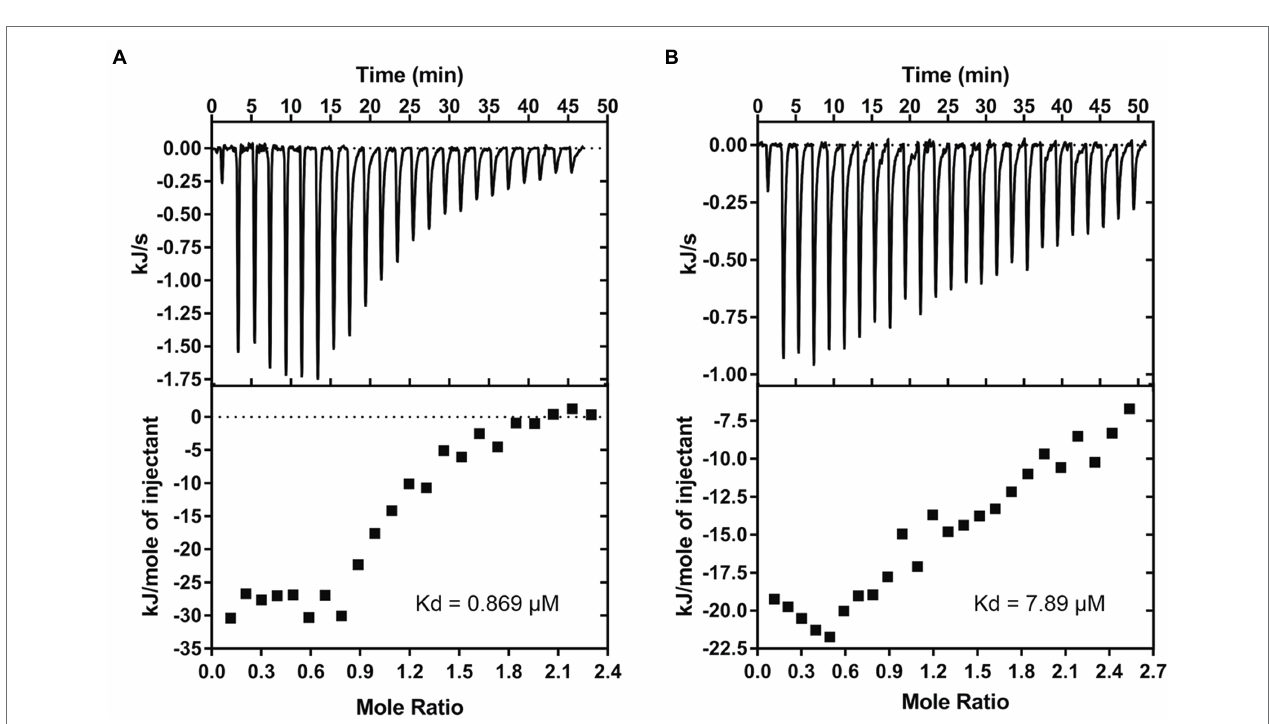
FIGURE 5 | Brevibacillins show good affinity to Lipid II. (A) , ITC-binding experiments of brevibacillin and phospholipid LUVs containing 2 mol % Lipid II. (B) , ITC-binding experiments of brevibacillin 2V and phospholipid LUVs containing 2 mol % Lipid II. The Kd values of brevibacillins to Lipid II were calculated using the Nano Analyze Software (Waters